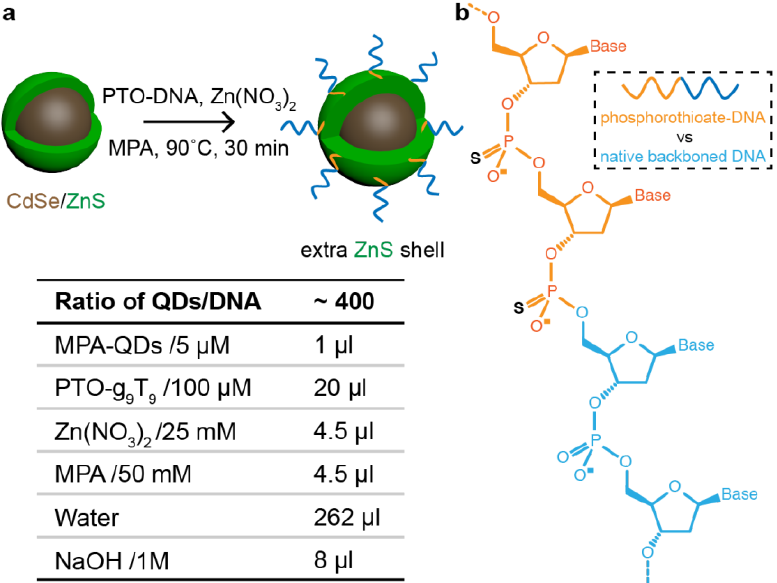
Figure 1. Schematic illustration of incorporating phosphorothiolated DNA oligonucleotides (PTO-DNA) into a freshly-grown ZnS shell. ( a ) PTO-DNA in situ attachment to the extra layers of ZnS shell and a table showing the different precursors; ( b ) Molecular structure of a chimera DNA strand showing two phosphorothiolated backbone bond (orange section) and one native bond (blue section). The black “S” highlights the atomic difference of the upper phosphate link. MPA: 3-mercaptopropionic acid.